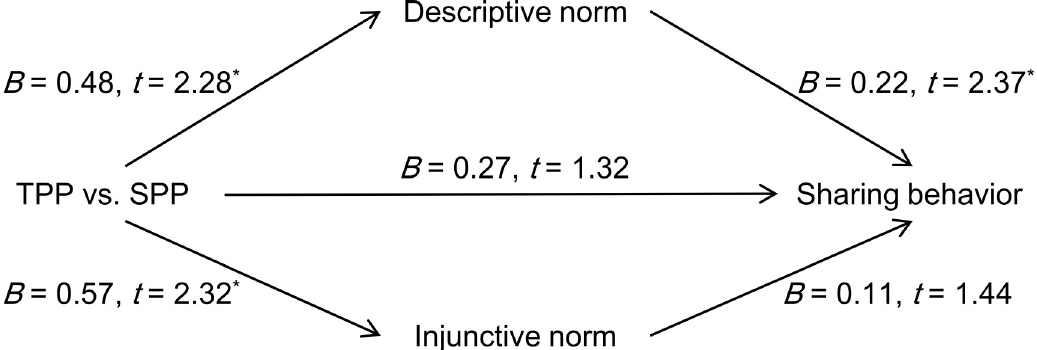
Fig 4. The influence of punishment source on observers’ sharing behaviors mediated by norm perceptions in Experiment 2 ( � p <